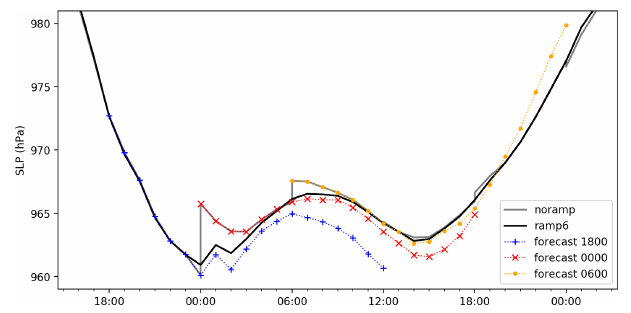
Figure 10. First 18h of ECMWF-IFS surface pressure (SLP) fore- casts at point 64.793, 0.773 (lat., long.) for epochs 23 Decem- ber 2016 18:00UTC, 24 December 2016 00:00UTC, and 24 De- cember 2016 06:0UTC. Also shown are the resulting forcing with- out use of ramping (noramp) and for a 6h ramping (ramp6).